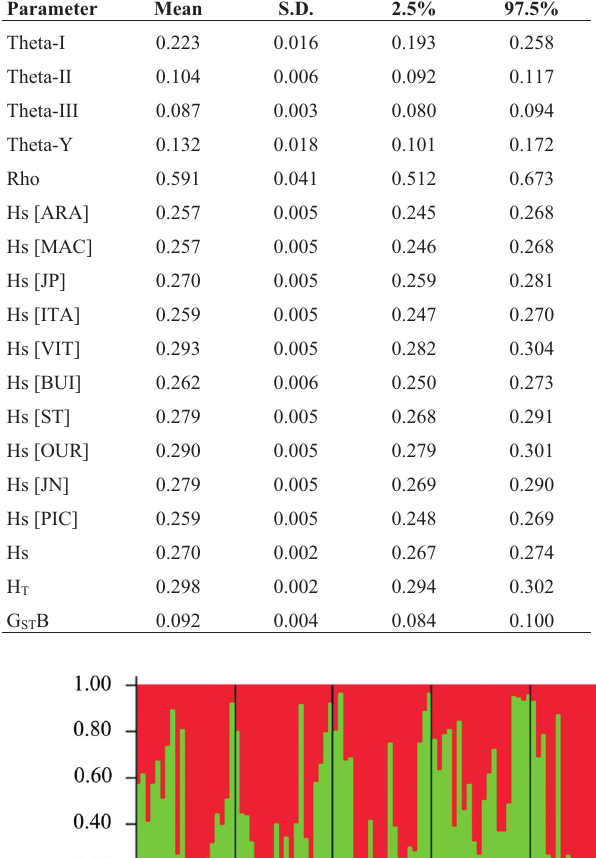
Table5 -ParametersestimatedbythesoftwareHickoryforthemodel f =0. Parameter